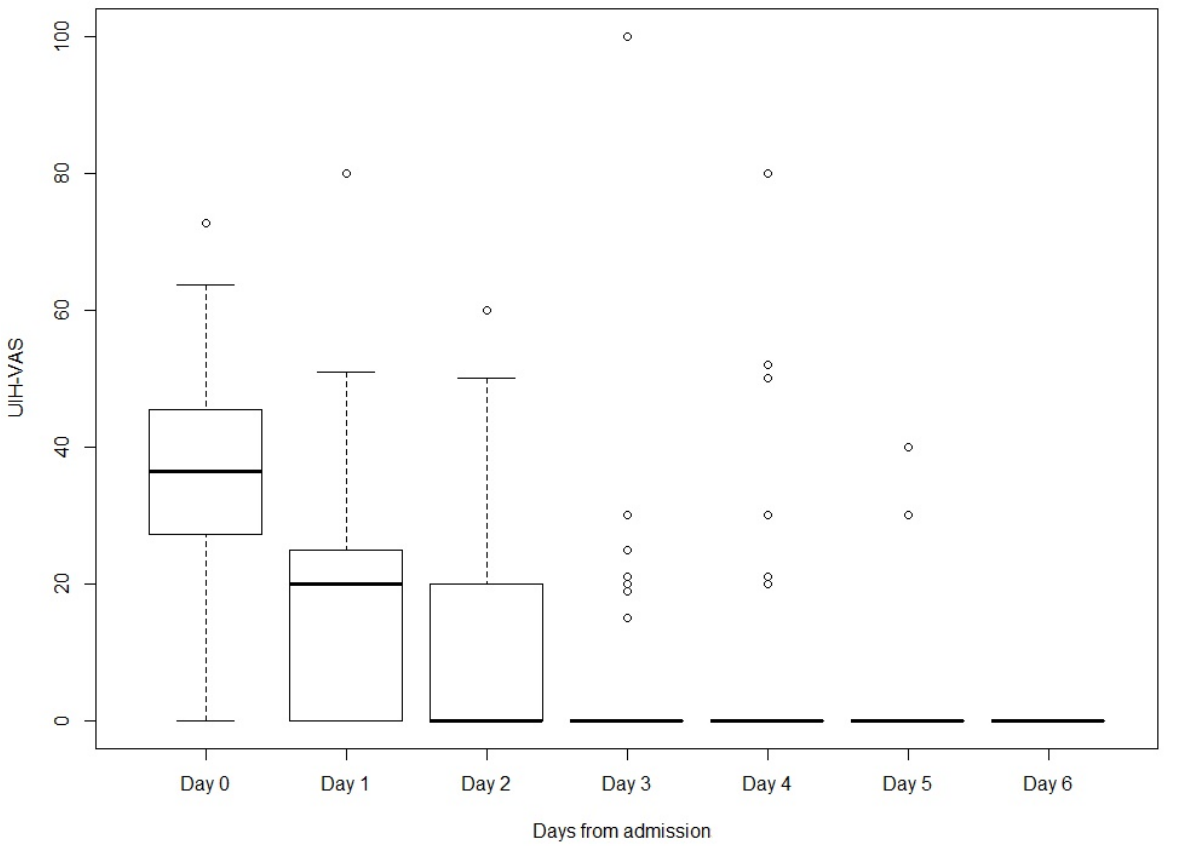
Figure 1. Use of Internet Health-information Questionnaire (UIH)-visual analog scale (VIS) levels over the days spent in